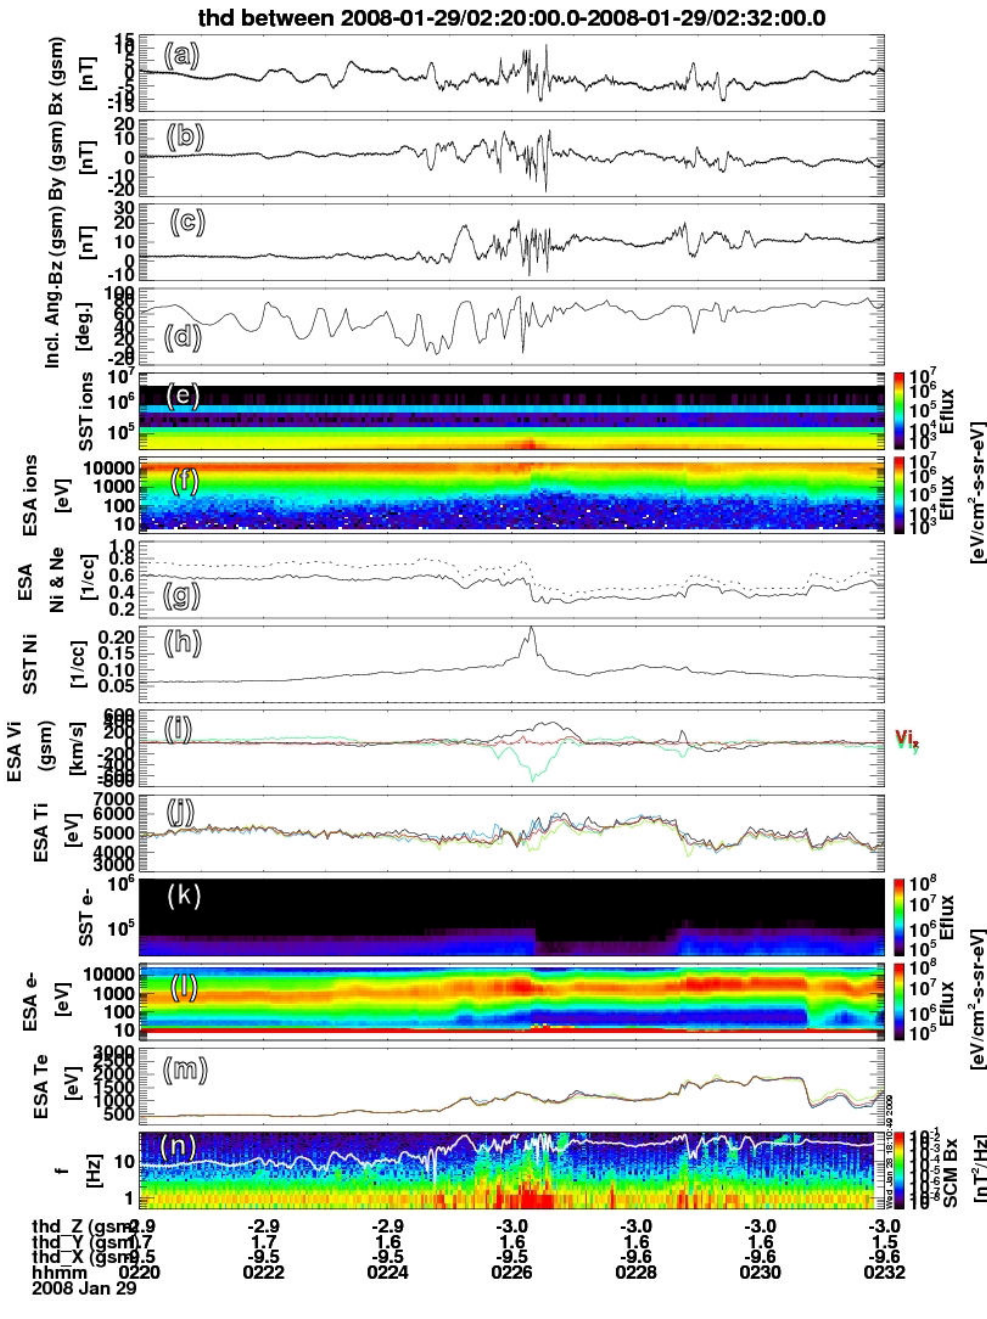
Fig. 3. Panels (a, b, c, d) three components (128S/s) and inclination angle (3s) of the magnetic field in GSM coordinates, (e) ion energy spectra from SST and (f) ESA (3s), (g) ion (solid line) and electron (dotted line) densities from ESA, (h) ion density from SST, (i) ion velocity from ESA in GSM coordinates (Vx:black, Vy:green, Vz:red), (j) ion temperatures from ESA (Txx:black,Tyy:green,Tzz:red,Tav:blue, the averaged temperature Tav=(Txx+Tyy+Tzz)/3), (k) electron energy spectra from SST and (l) ESA, (m) electron temperatures from ESA (same color code as ions), (n) B x power spectral density from SCM (2s) from 0.45 to 64Hz in GSM coordinates. Superimposed white curve corresponds to 0 . 1 | (cid:127) e | /( 2 π)